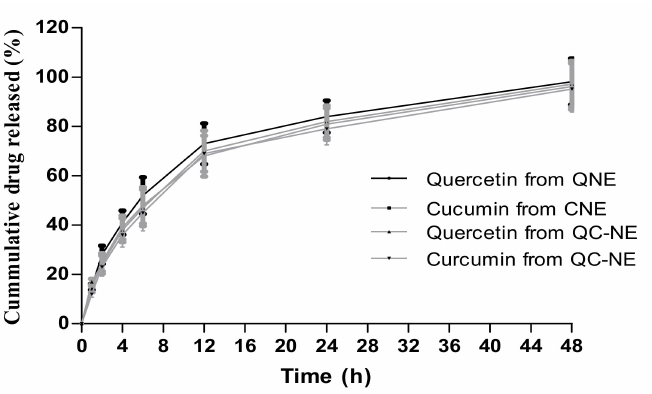
Figure 2. Percentage cumulative release of quercetin and curcumin form nanoemulsion formulations at different time